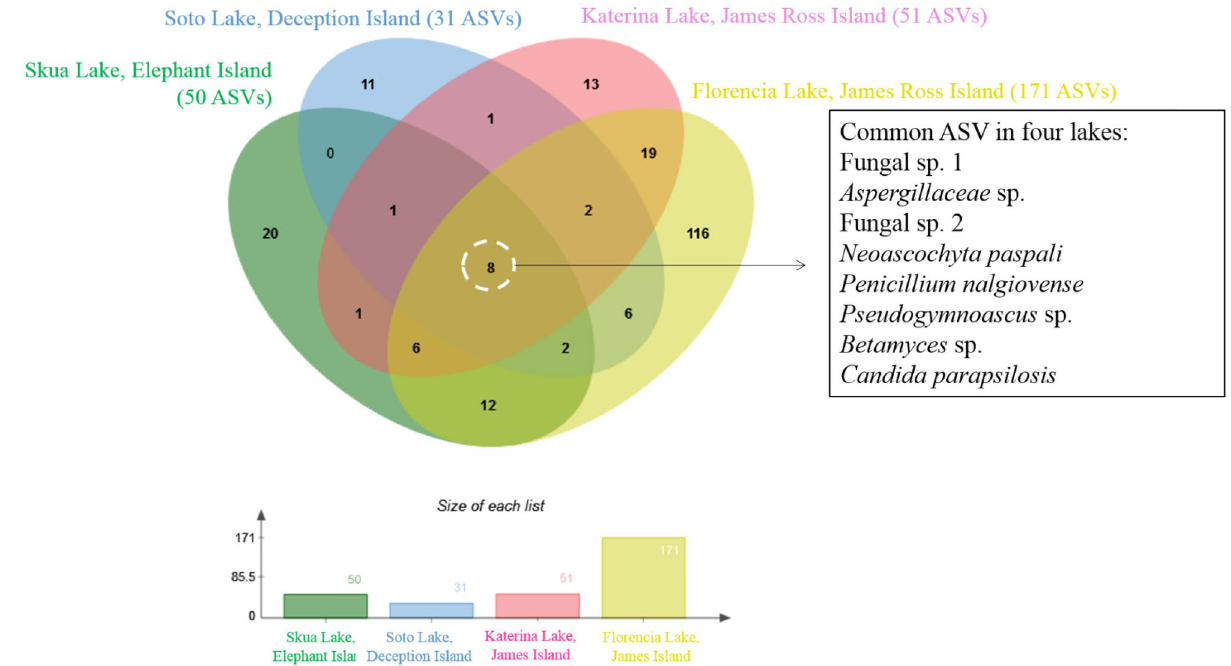
Figure 2. Venn diagram showing the distribution of fungal amplicon sequence variants (ASVs) among the sediment samples obtained from Skua Lake (Elephant Island), Soto Lake (Deception Island), Katerina Lake and Florencia Lake (James Ross